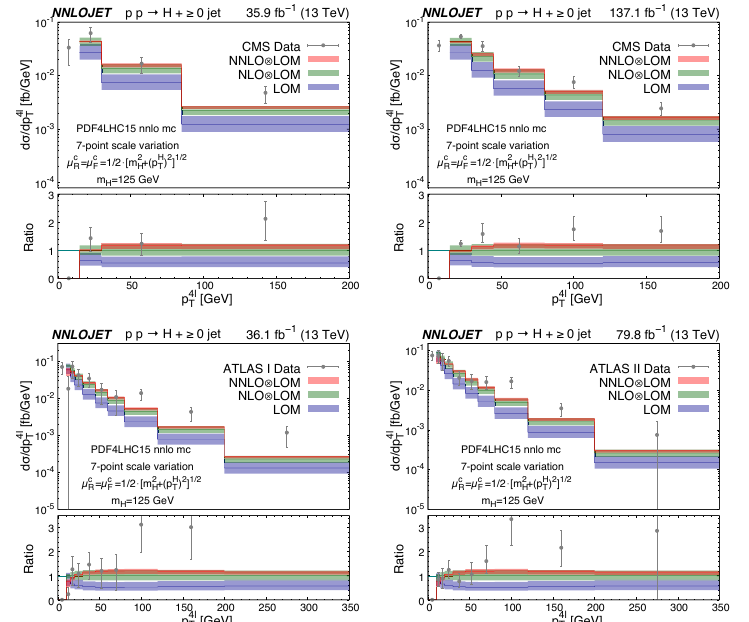
Figure 10. Transverse momentum distribution of the Higgs boson for CMS [ (cid:31) (upper-left) and [ (cid:31) dt = 137.1 fb − 1 ] (upper-right), ATLAS I [ L ATLAS II [ (cid:31) dt =79.8 fb − 1 ] (lower-right) cuts and integrated L